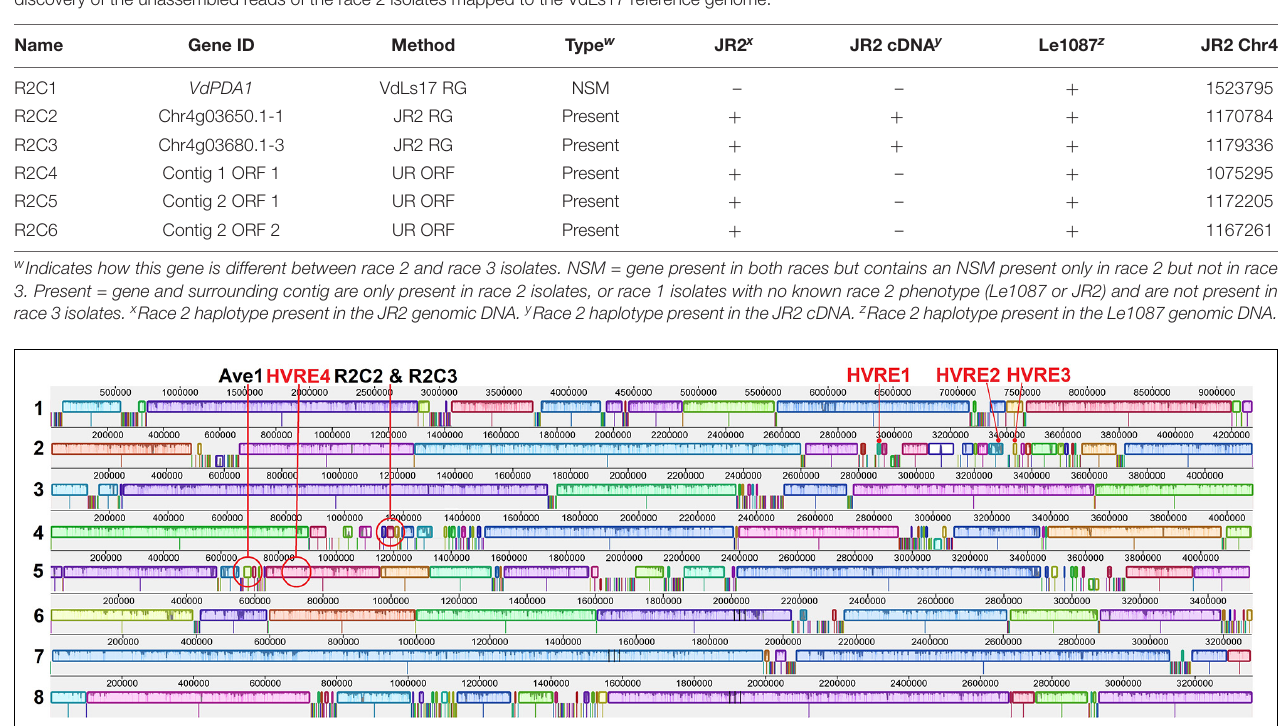
TABLE 5 | Race 2 candidate effectors (R2C1-6) from three different discovery methods: VdLs17 reference genome; JR2 reference genome; and an ab initio gene discovery of the unassembled reads of the race 2 isolates mapped to the VdLs17 reference genome.